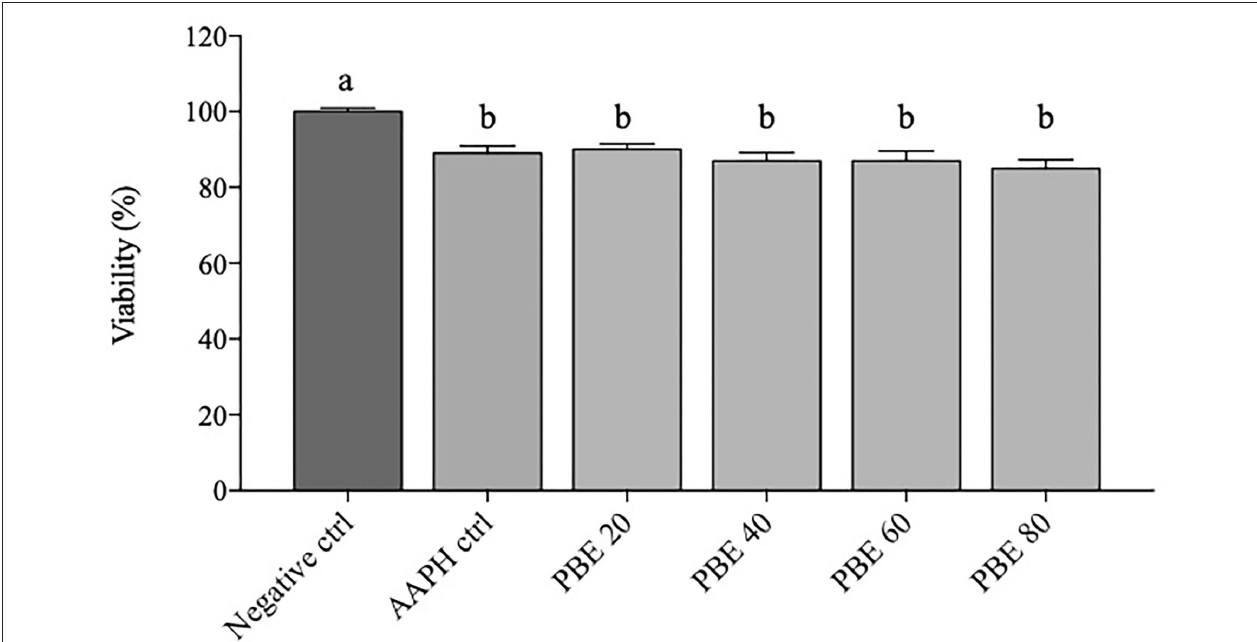
FIGURE 1 | Data of BAECs viability are expressed as percentage (%) calculated on negative control. Percentage changes in BAECs viability treated with 20, 40, 60, and 80 µ g/ml concentration of PBE after 6h of 5mM AAPH stimulation. Dark gray bars represent negative control. Light gray bars represent AAPH control and different treatments (PBE 20 = pomegranate 20 µ g/ml, PBE 40 = pomegranate 40 µ g/ml, PBE 60 = pomegranate 60 µ g/ml, PBE 80 = pomegranate 80 µ g/ml). Different letters ( a,b ) represent significant difference ( p < 0.05). Error bars represent